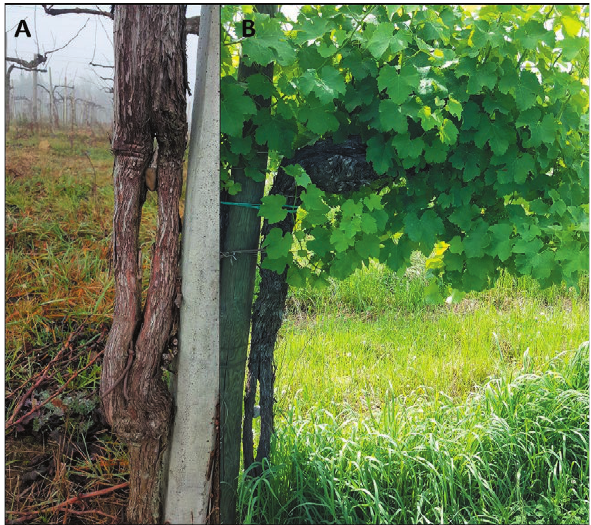
Figure 1. ‘Low-tech’ grapevine trunk surgery (known in some Ital- ian regions as ‘ Metodo Armano ’). It consists of splitting the trunk of a leaf symptomatic vine and fitting a stone in between the two trunk halves. These two treated vines were photographed in December 2016 (A) and in June 2017 (B), in two vineyards near Spessa, Friuli,